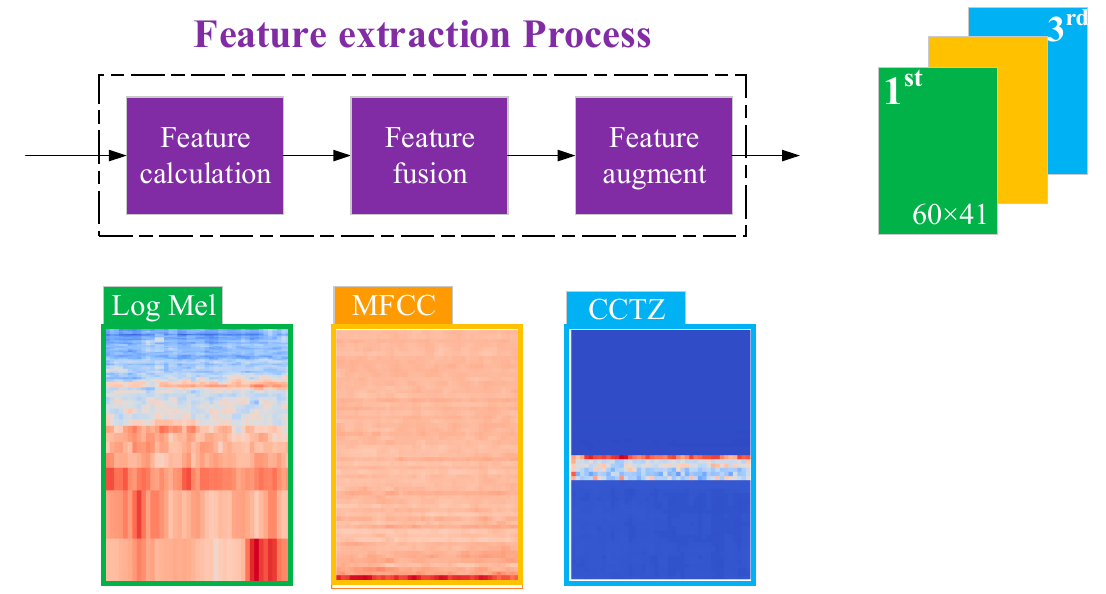
Figure 3. The depiction of the feature extraction process.